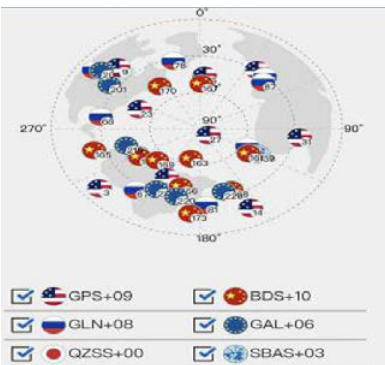
Figure 10. satellite sky distribution of observation points